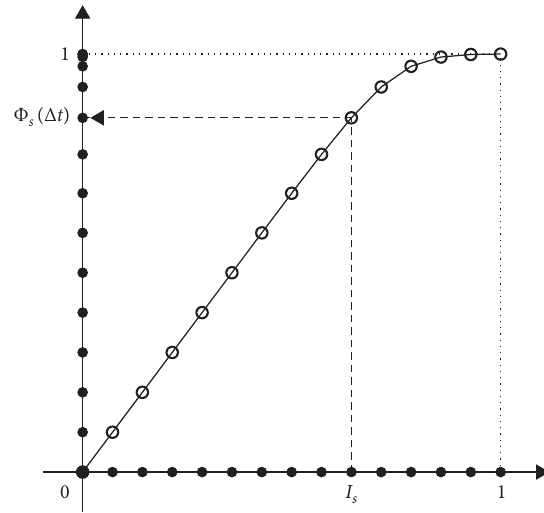
Figure 1: Numerical solution Φ ( Δ t ) of equation (6) on the uni- form grid I .